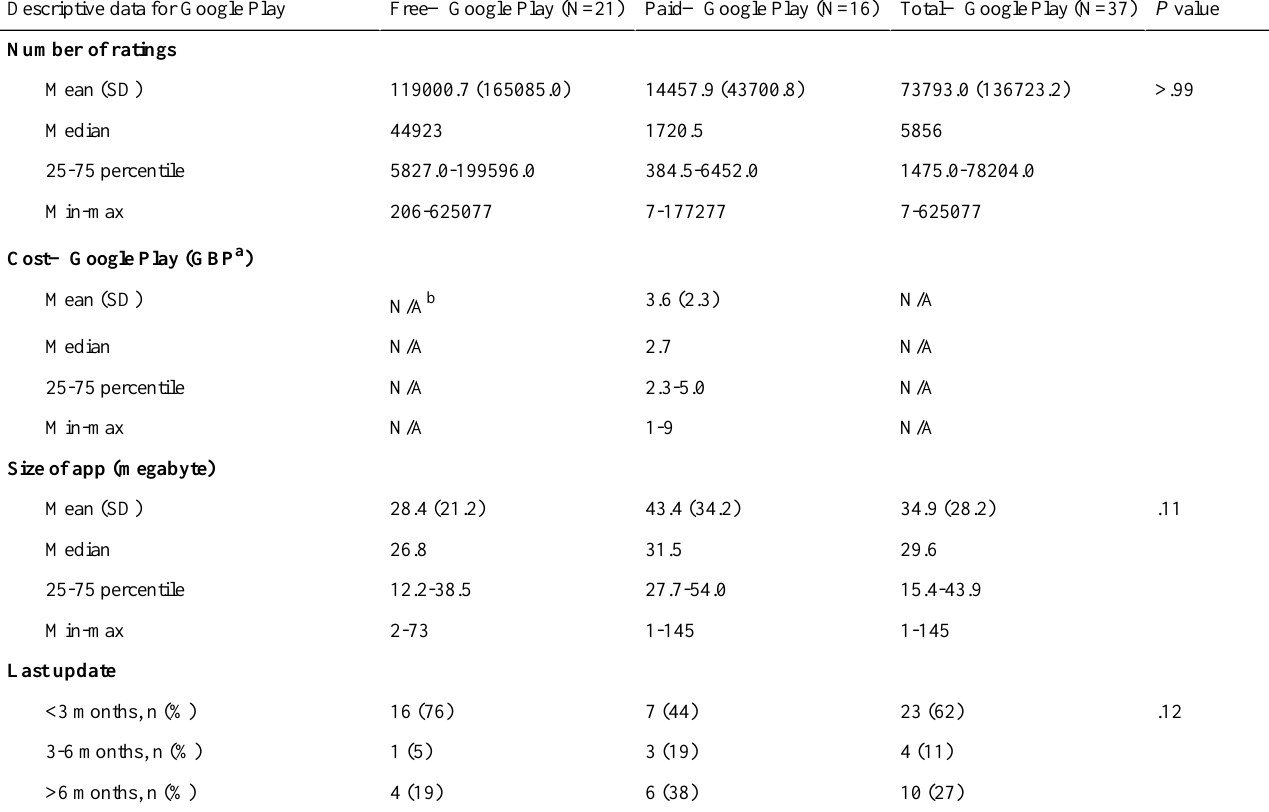
Table 3. Descriptive data for Google Play